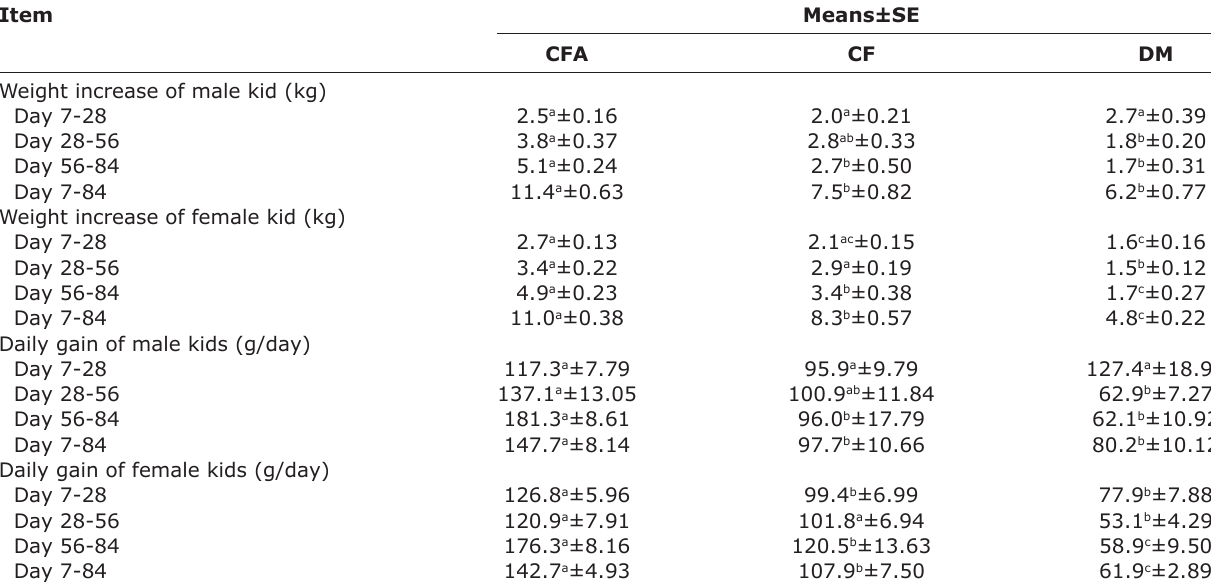
Table-5: Weight changes and ADG of male and female kids from CFA, CF and DM groups (n=8).